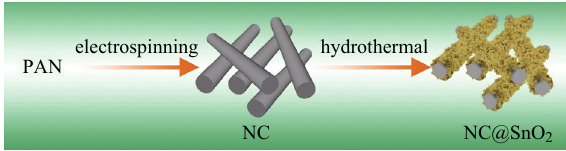
Fig. 1 Schematic diagram for synthetic process of NC@SnO 2 . (Color figure online)